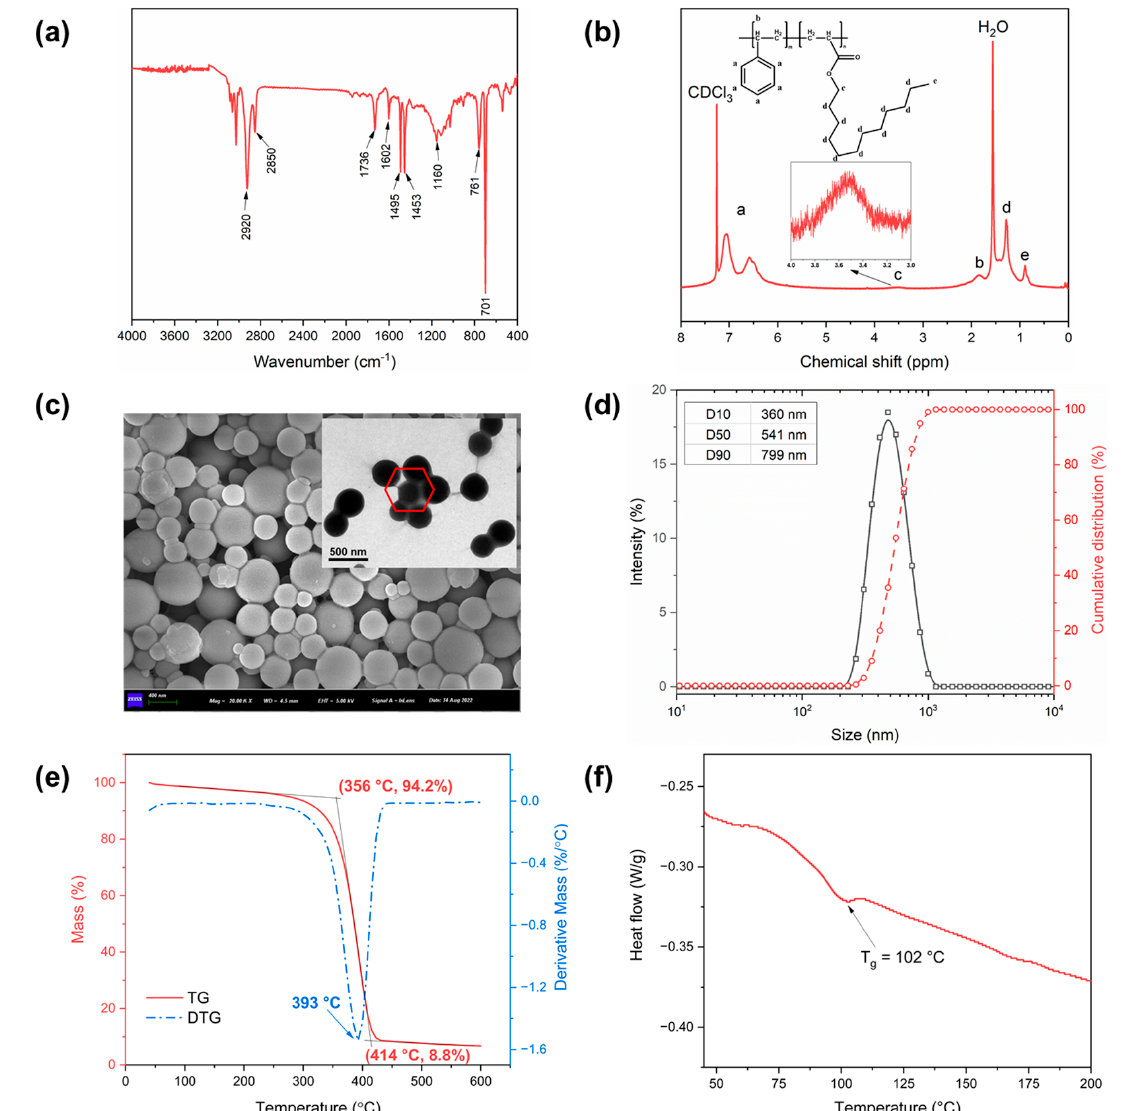
Figure 1. FTIR spectrum ( a ), 1 H NMR curves ( b ), micromorphology images ( c ), particle size distribution curve ( d ), TG analysis ( e ), DSC curve ( f ) of PSL rubber nanogels.